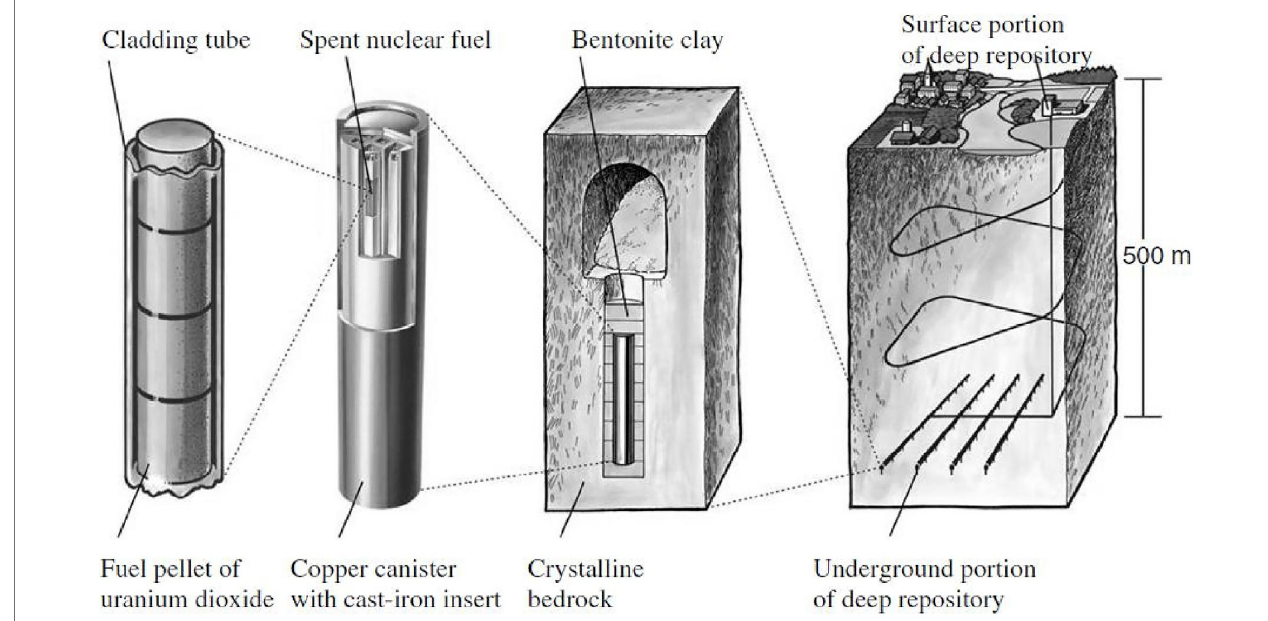
FIGURE 1 | Multi-barrier system of high-level nuclear waste (Duquette et al., 2009).